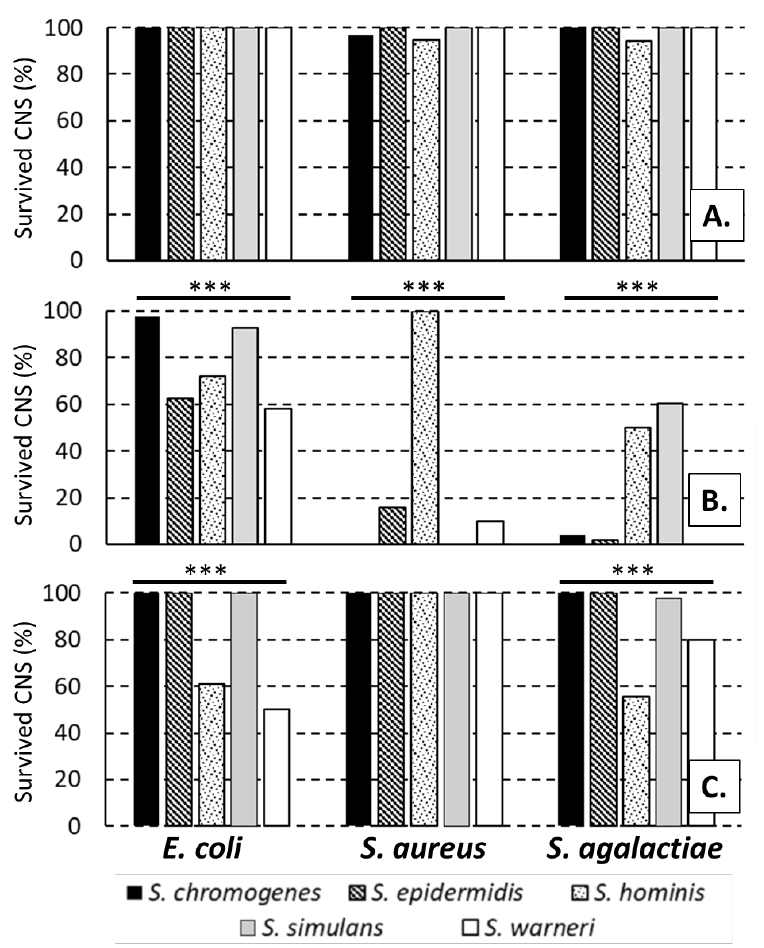
Figure 2. Percentage of the survival ability of CNS strains toward major strains in ( A ) PRIOR condition 1 and 24-h prior incubation with CNS; ( B ) AFTER condition 2 and 24-h prior incubation with major pathogens; ( C ) EQUAL condition 3, starting incubation at the same time. *** Indicated the significant difference in survival rates between species when incubated with the specified major strains at p <